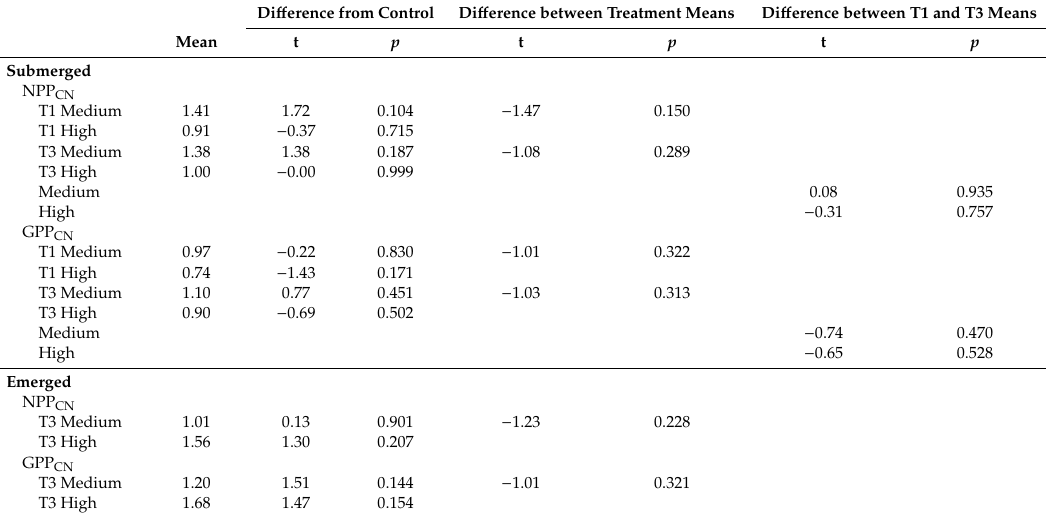
Table 3. t -test results examining nutrient treatment e ff ects on control normalised (CN) primary production